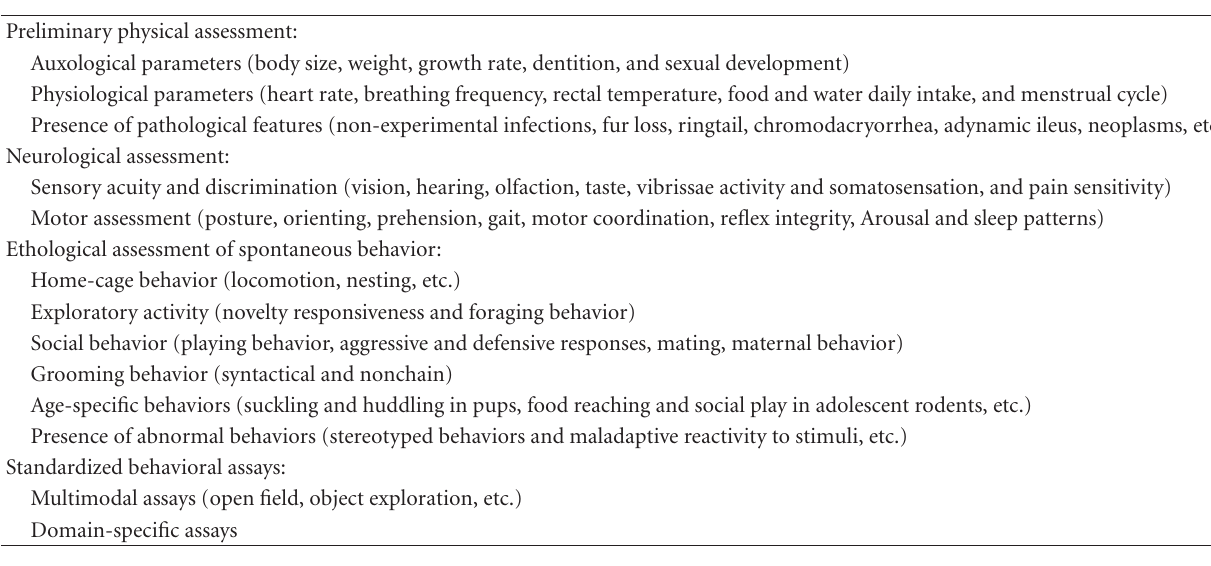
Table 1: Experimental protocol for phenotyping of neurobehavioral sequelae of experimental infections in rodents. Preliminary physical